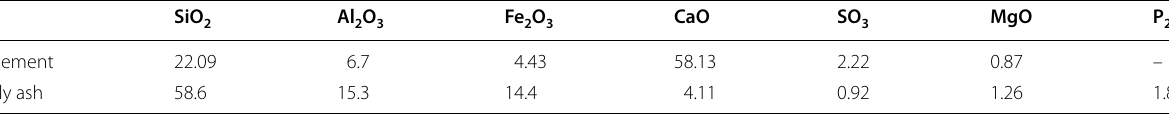
Table 1 Chemical composition of cement and fly ash (wt.%).